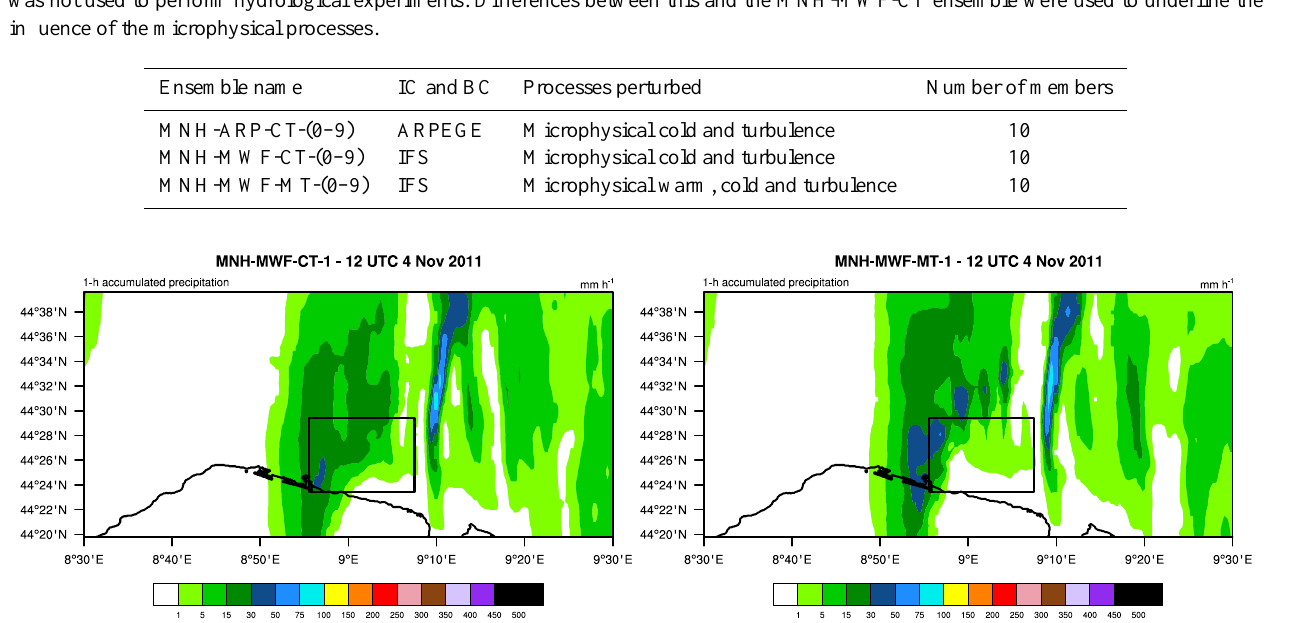
Figure 10. The 1h simulated rainfall amounts (in mm) for the MNH-MWF-CT-1 and MNH-MWF-MT-1 ensemble members at 12:00UTC on 4